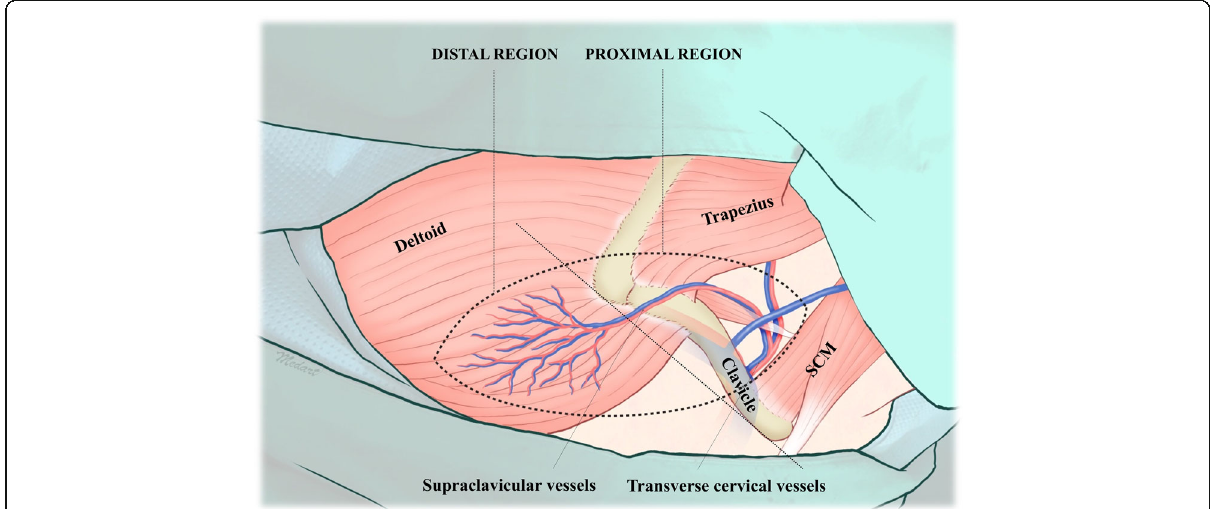
Fig. 1 Anatomy of the supraclavicular area (right side). Two regions were distinguished by dotted line depending on vascular flow pattern. Note the landmarks for the origin of supraclavicular